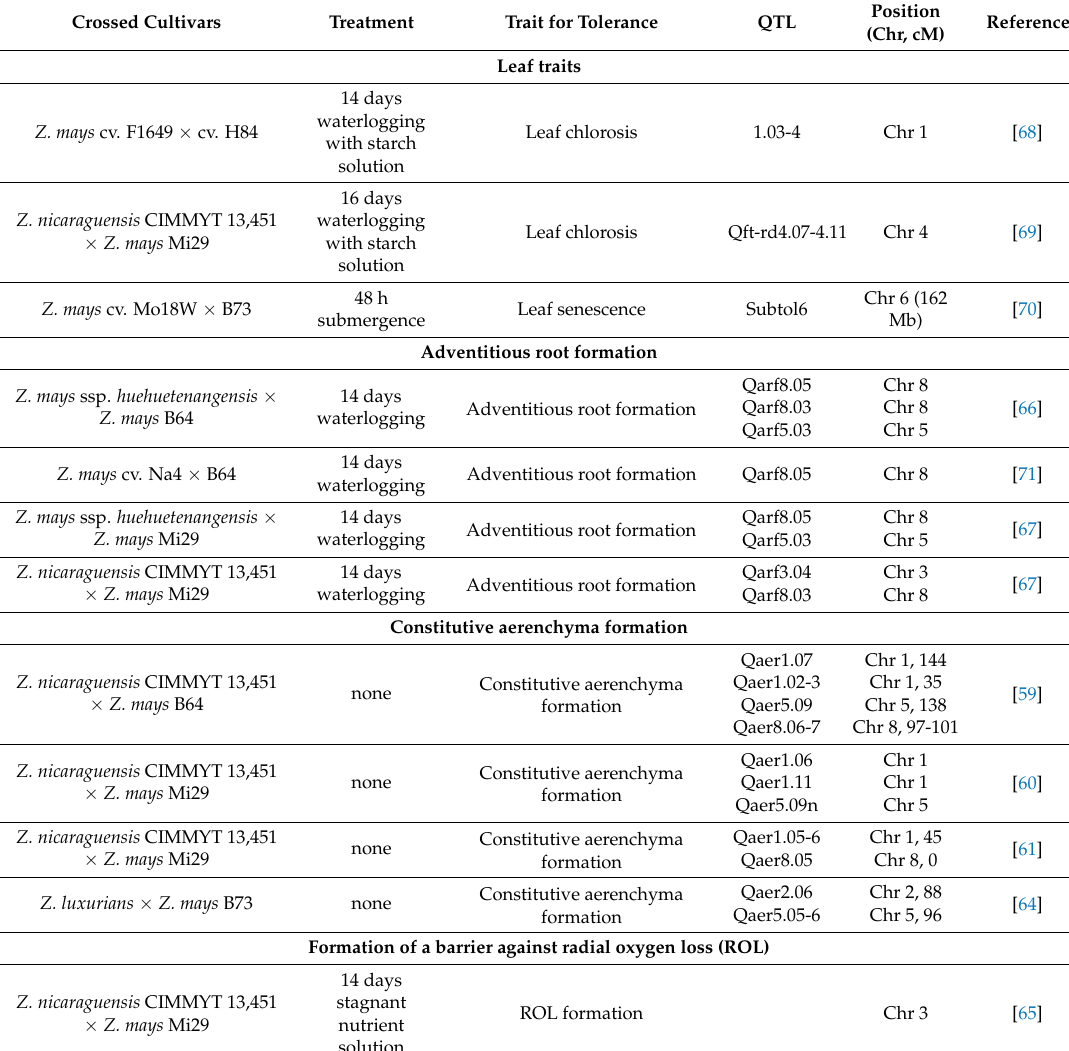
Table 2. Overview over promising QTLs to improve flooding tolerance of maize ( Zea mays L.). Crossed